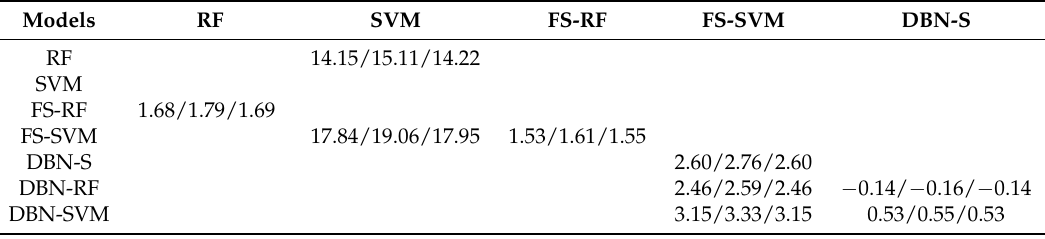
Table 12. The percentage deviation values (%) of overall accuracy, Kappa, F1-score between different models. RF: random forest. SVM: support vector machine. FS-RF: RF with feature selection